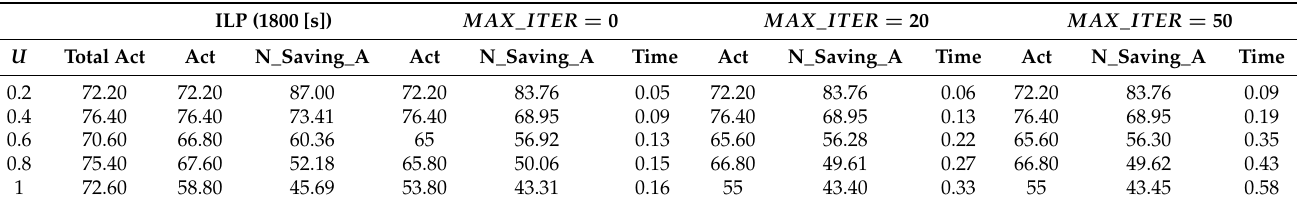
Table 5. Eight servers-30 flows-Activation scheduling—Phase 2